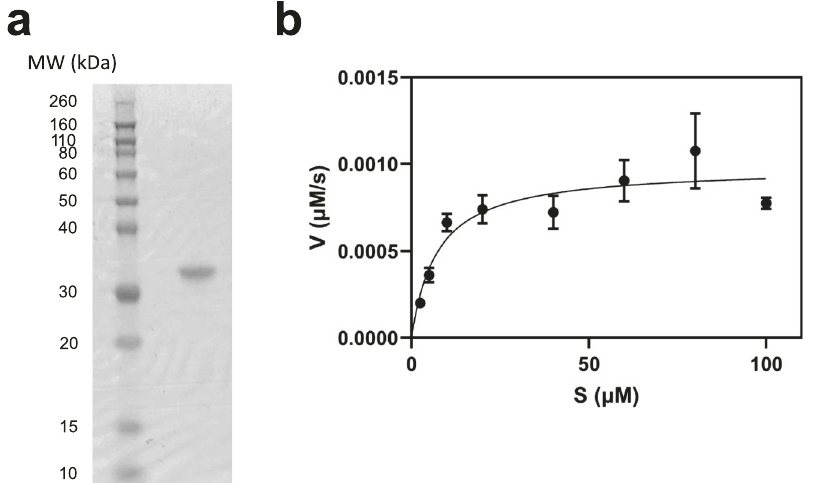
Fig. 1 Production of native SARS-CoV-2 3CL protease in E. coli . a The puri fi ed protease was ran on SDS-PAGE to con fi rm size and purity. b Con fi rmation of enzymatic activity of SARS-CoV-2 3CL protease by quanti fi cation of cleavage of a fl uorogenic peptide substrate. K m was 7.22 ± 2.48 µ M, V max was 1 ± 0.08 nM/s, and catalytic ef fi ciency ( k cat / K m ) was 6,925 M − 1 s − 1 . Data are shown as mean ± s.e.m. for three independent biological replicates. MW molecular